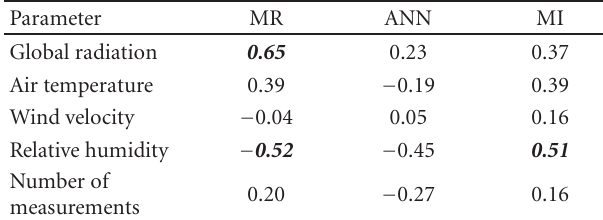
Table 6: Correlation coe ffi cients between the biases (MSB) of the three gap-filling methods and meteorological parameters involved in the analysis.Valueswritten in bold are significantat the 0.01